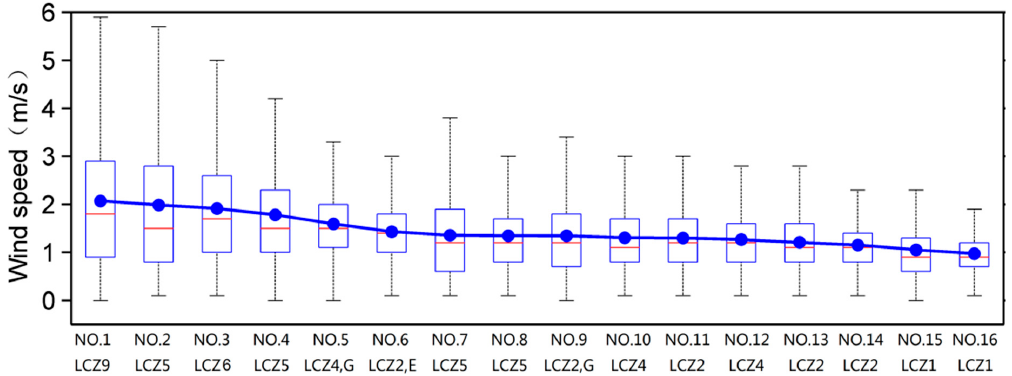
Figure 3. Boxplot and mean wind speed (blue point-fold line) of the 16 stations.